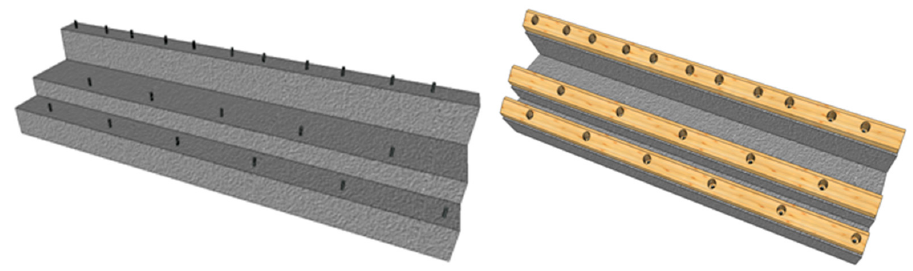
Figure 7. The basement and the larch elements.